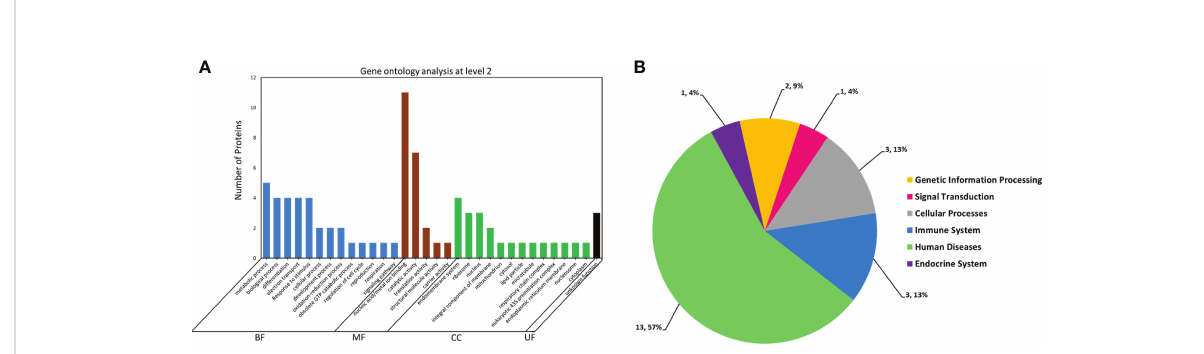
FIGURE 2 Functional annotation and pathway analysis of 21 white fl y proteins putatively interacting with CLCuMuV-AV1. (A) Gene ontology (GO) analysis of 21 white fl y proteins. The protein functional categories associated with the biological function (BF), molecular function (MF), cellular component (CC) and unknown function (UF) were de fi ned using Blast2GO software available online at (https://www.blast2go.com/). (B) Metabolic pathway distribution of these proteins was analyzed by using online BlastKOALA tool in Kyoto Encyclopedia of Genes and Genomes (KEGG) database available online at